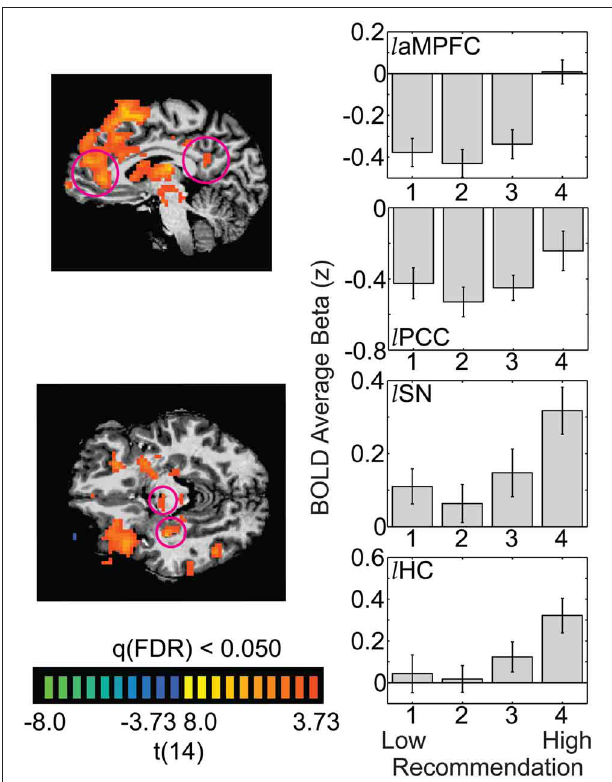
FIGURE 6 | The default mode network and several subcortical regions show increased activation for only the most aesthetically pleasing images. The whole-brain images illustrate the t -statistic for the 4-vs.-321 contrast. Panels on the right illustrate the average beta weight (as a z -score) for each recommendation level, averaged across 15 observers ( l aMPFC = left anterior medial prefrontal cortex; l PCC = left posterior cingulate cortex; l SN = left substantia nigra; l HC = left hippocampus). Error bars are standard errors of the mean across